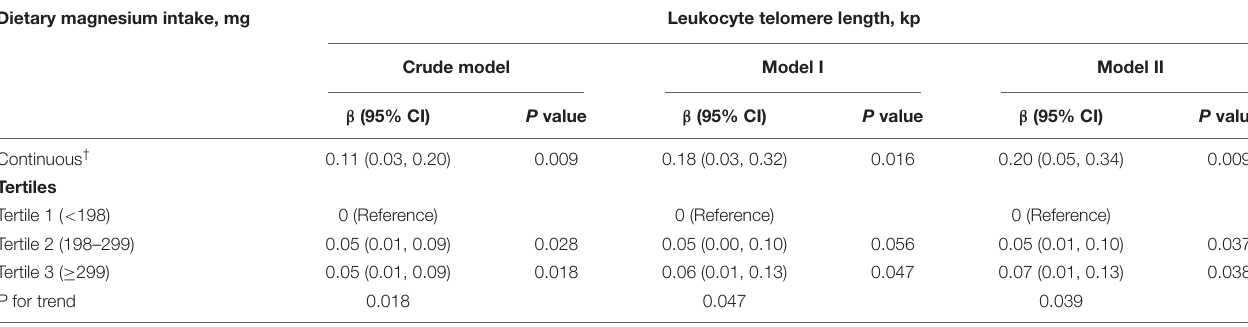
TABLE 2 | Association of dietary magnesium intake with leukocyte telomere length among middle-aged and elderly population ( n = 4,039). Dietary magnesium intake, mg